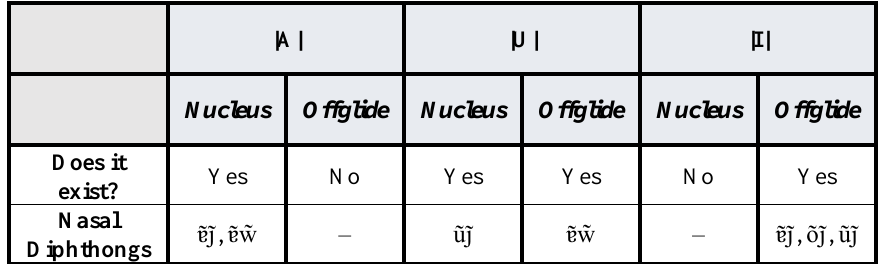
Table 6. Distribution of |A I U| elements in the nucleus of a lexical nasal diphthong in